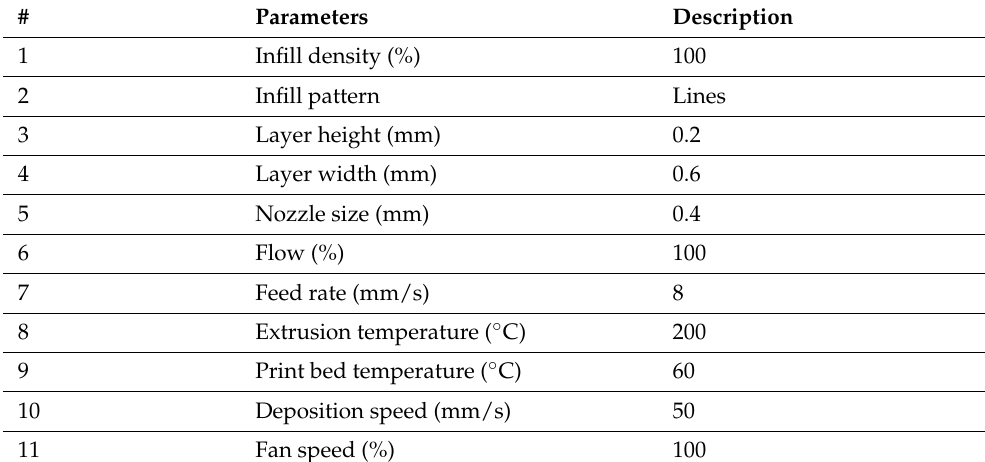
Figure 3. Dimensions of the dog-bone sample. Table 1. Process parameters for PLA printing.